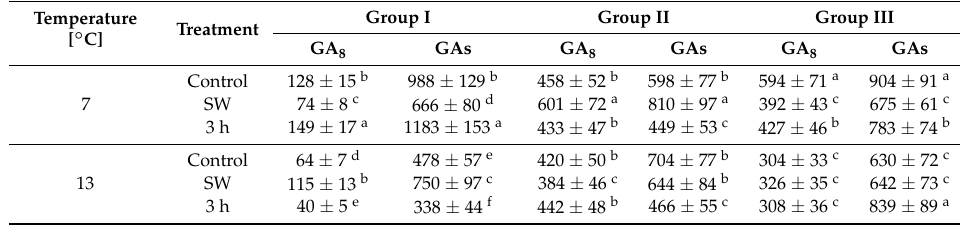
Table 3. Effect of smoke water (SW) and 3-h hydropriming (3 h) on GA 8 and active gibberellin content (fmol g − 1 DW) in the seeds of Lupinus angustifolius lines/cultivars germinating at low (7 ◦ C) and control (13 ◦ C) temperature categorized into three groups: I, weakly germinating; II, well germinating; III, very well germinating. Control—non-stimulated